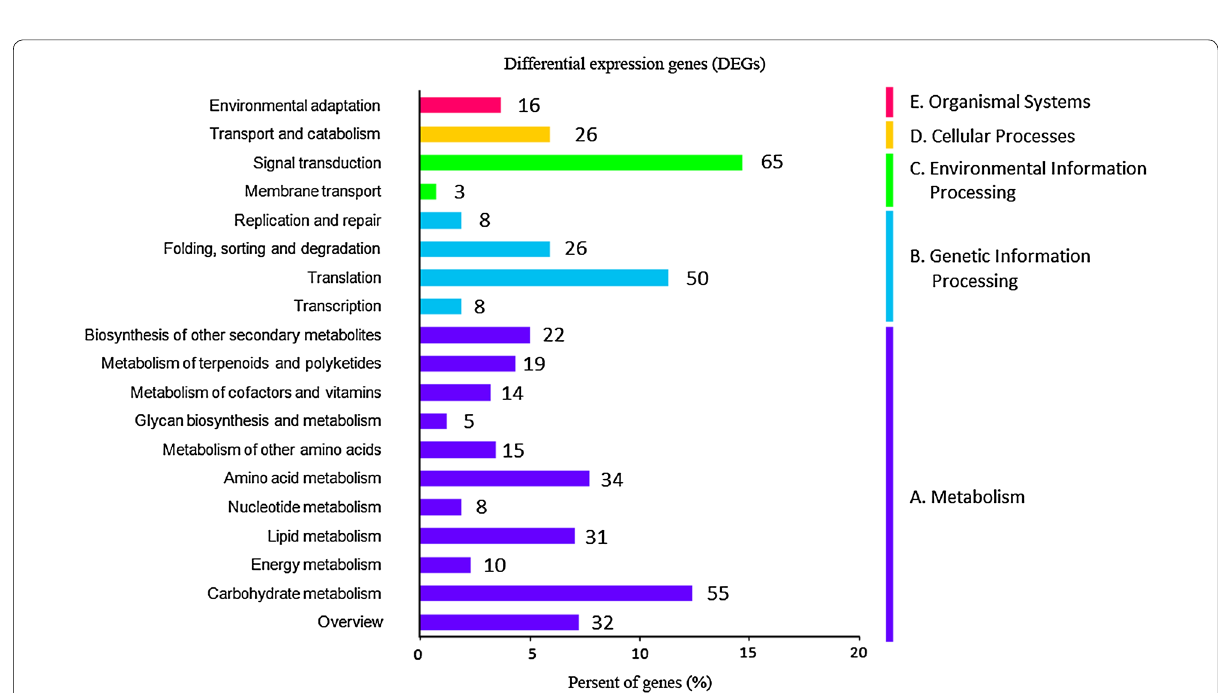
Fig. 4 KEGG pathway enrichment scatter diagram of differential expression genes (DEGs) in seeds vs.